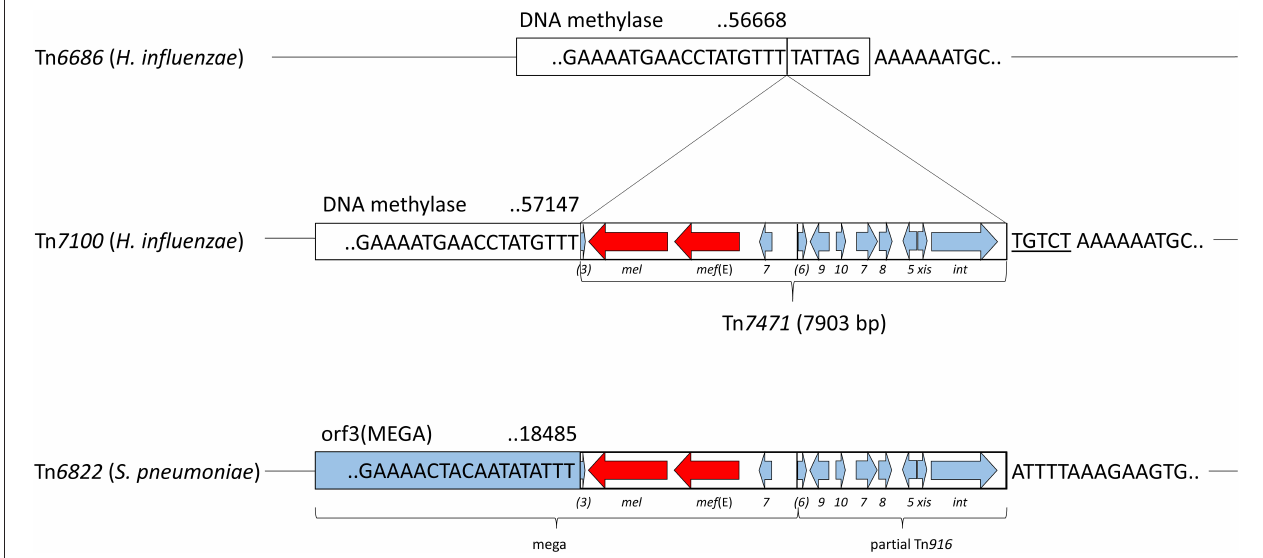
FIGURE 3 | Schematic presentation of the transposable element Tn 7471 , representing 10.7% of Tn 7100 . Refer to Figure 1 for location on Tn 7100 . Tn 7471 consists of a 7,903-bp insertion in the DNA methylase gene (QEA08786) and has a 99.49% identity to a fragment of the conjugative transposon Tn 6822 (MT489699) in Streptococcus pneumoniae strain 080217 (NZ_JABAHD010000004, bottom). Top; fragment of Tn 6686 (MN106411) with a vertical line indicating the insertion site, 6 bp within the end of the DNA methylase gene. Tn 7471 contains a truncated macrolide efflux genetic assembly (mega) element (AF274302) with orf3 (incomplete), macrolide resistance genes mef (E) and mel, and orf7 of mega. Furthermore, Tn 7471 contains eight genes of the conjugative transposon Tn 916 (U09422); orfs 5-10 ( orf6 incomplete), and the xis- Tn and int- Tn genes associated with excision and integration in conjugative transposition. The junction between mega and Tn 916 is indicated by a vertical line. A tentative 5-bp coupling sequence is indicated on the right flank of Tn 7471